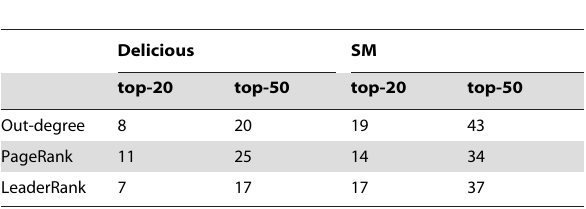
Table 5. The number of different nodes in the top- L lists between ClusterRank and other three methods for Delicious and SM